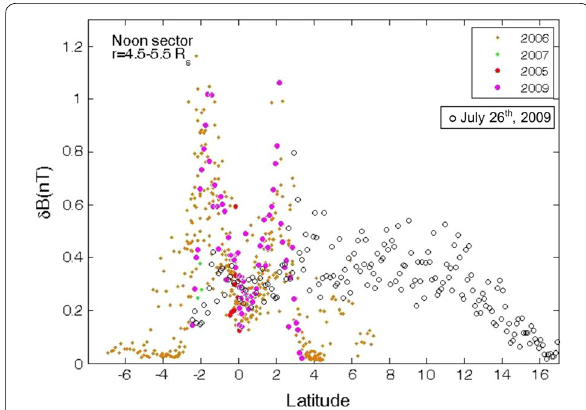
Fig. 9 The latitude dependence of the averaged perturbed magnetic field amplitude δB in the radial distance range of 4.5–5.5 R S for the noon sector for the data from 2005, 2006, 2007 and 2009. Each point represents the averaged δB within a small region of Δ θ Δ R 1 R s when Cassini passed through. It is noted that the latitude = distribution of δB on July 26, 2009, peaked at ~10° which is different from the other data that show the δB peaks are at